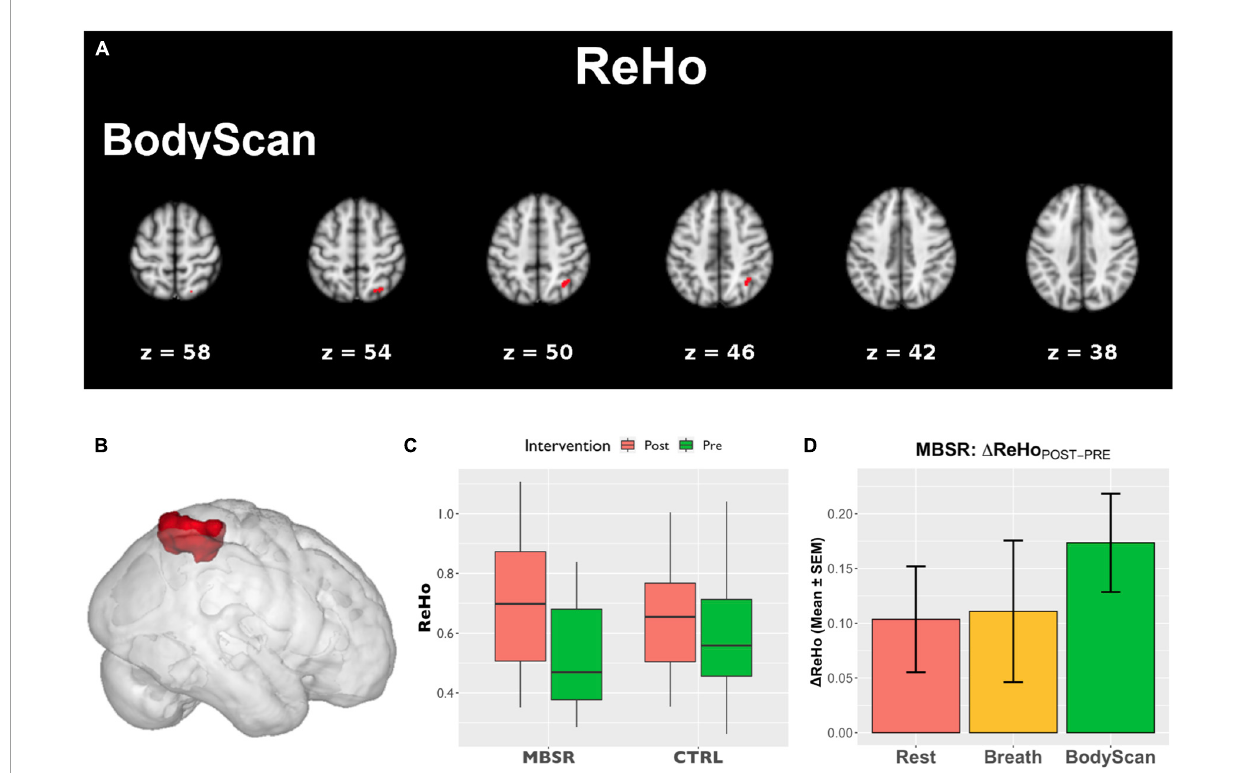
FIGURE3 The analysis of ReHo. (A) Areas that showed POST–PRE differences of ReHo in TFCE ( p < 0.05, FDR-corrected); (B) ROI of the right angular gyrus and parietal lobe extracted from Yeo 400 template; (C) the ROI-based boxplot presenting the group × time interactions; (D) the repeated-measure ANOVA of the ReHo changes in the MBSR group, and the error bars in (D) stands for standard error of the means (SEM).